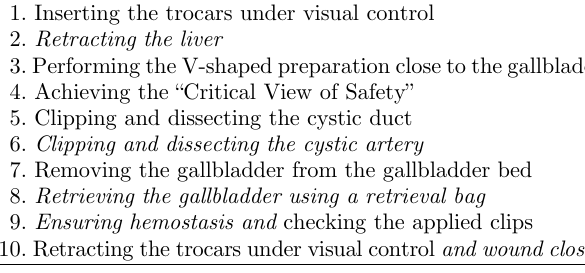
Table 1. Nodal points of a standardized laparoscopic cholecys- tectomy at the surgical training center in Tübingen; substeps in italics were excluded due to the design features of the box trainer and to increase the ef fi ciency of the study